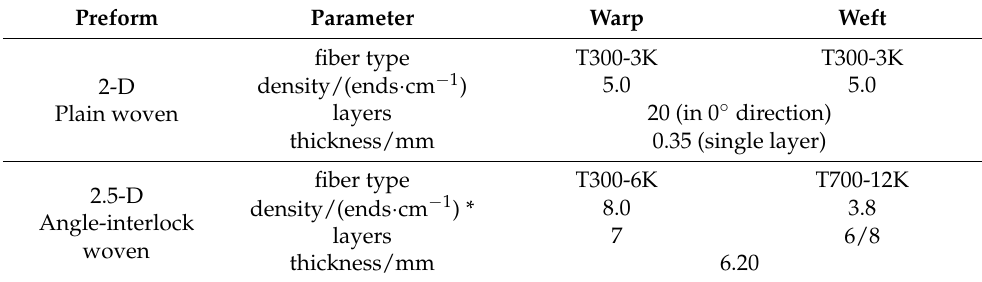
Figure 1. Structure of 2-D plain woven fabric and 2.5-D angle-interlock woven fabric. Table 3. Manufacturer Specifications.